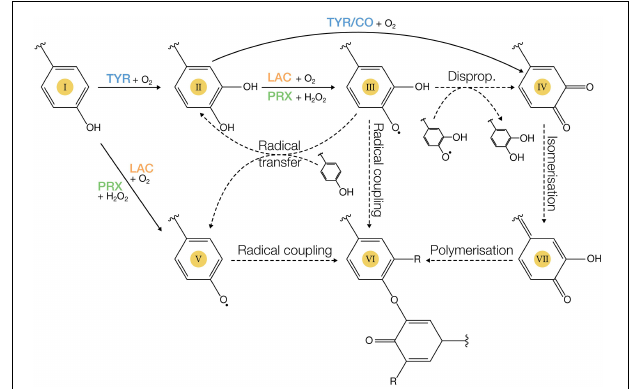
FIGURE 4 | Classical reactions catalysed by PPOs (CO, catechol oxidase; TYR, tyrosinase), LACs, and class III PRXs. Enzymatic and non-enzymatic reactions are indicated with solid and dashed arrows respectively on the example of simple mono- and diphenolic molecules. Monophenol hydroxylation (I → II) is generally considered to be exclusive to TYRs. The one electron oxidation of diphenols (II) by LACs or PRXs leads to a semiquinone radical (III). This can then couple with another semiquinone to form a dimer or polymer (VI), transfer its radical to another compound (III + I → II + V), or disproportionate with another semiquinone to form a quinone (2 III → IV + II). Quinones (IV) can isomerise to quinone methides (VII), which undergo non-enzymatic coupling reactions to form dimers (VI). Lastly, LACs and PRXs can also oxidise monophenols (I) into phenoxy radicals